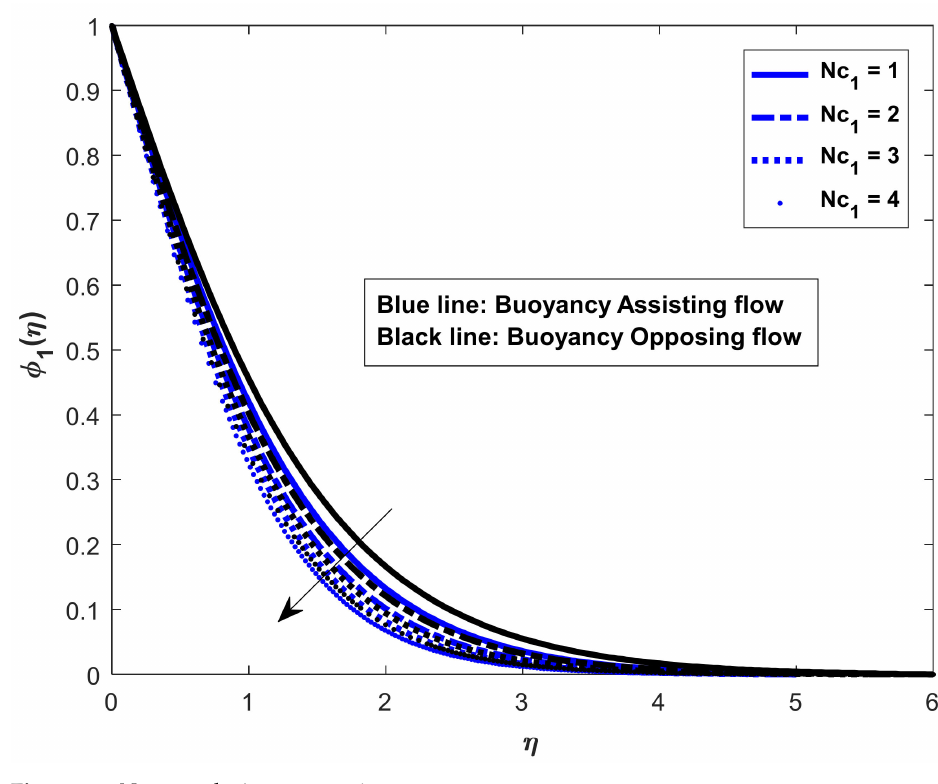
Figure 11. Nc 1 on salt_1 concentration.